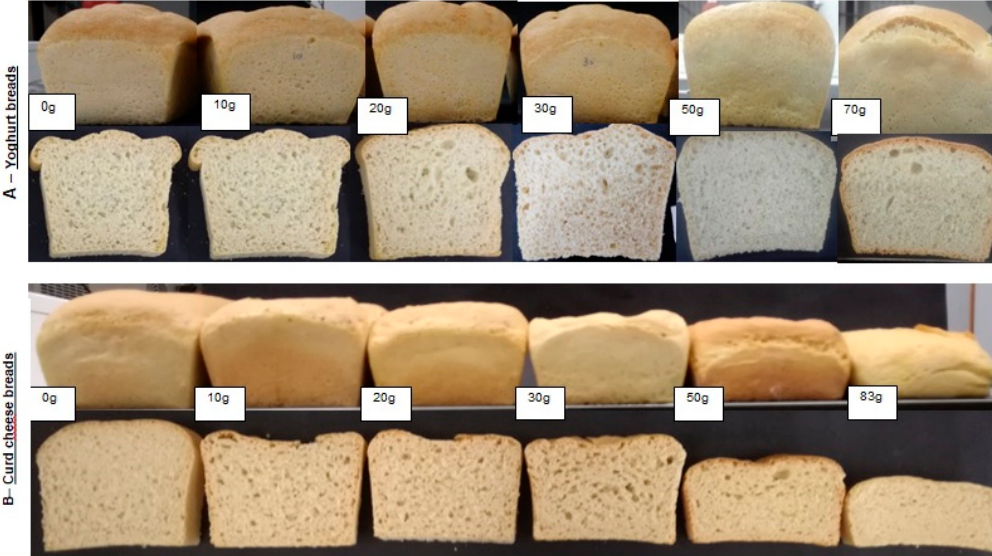
Figure 4. Breads obtained with di ff erent levels of yoghurt ( A ) and curd cheese ( B ) incorporation: 10 g, 20 g, 30 g, 50 g and 70 g Yg, and 83 g Cc / 100 g wheat flour, compared to control bread (without dairy product, 0 g / 100 g wheat flour).